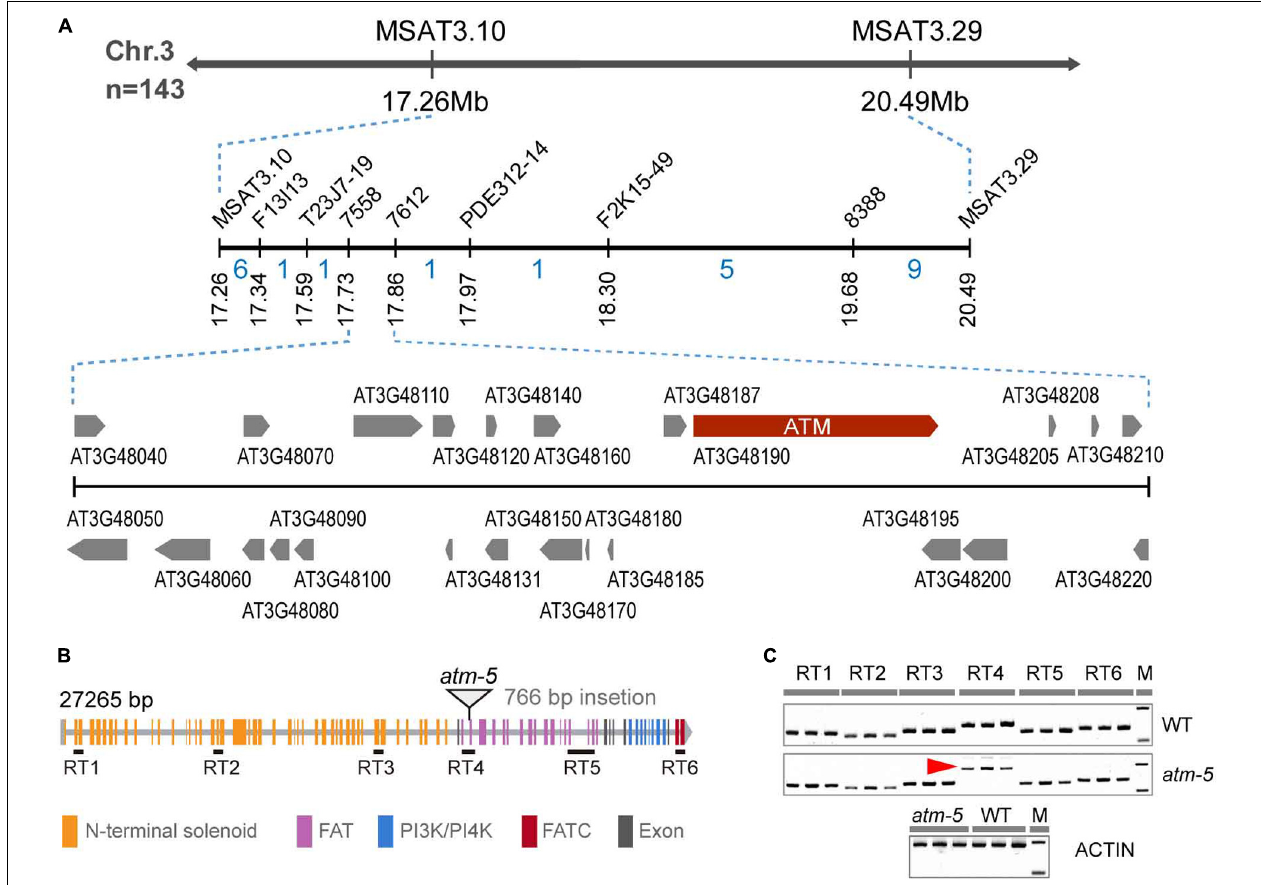
FIGURE 2 | Identification of the mutated gene in the mutant. (A) The fine-linkage map generated by analyzing 143 line 184 × Col-0 F2 segregating plants. The recombinant numbers are given between markers. (B) Diagram of ATM gene, the triangle showing the position of 766 bp insertion. All the colored rectangles represent an exon and each color indicates gene coding regions of corresponding protein domains. (C) RT-PCR detection of ATM transcripts. Six pairs of primers (30 cycles of PCR) were used to analyze the transcript and the location of these primer pairs was shown in (B) . The red arrow indicated the abnormal transcription products of ATM detected in atm-5 . Amplification of the ACTIN cDNA has been used as a control (25 cycles of